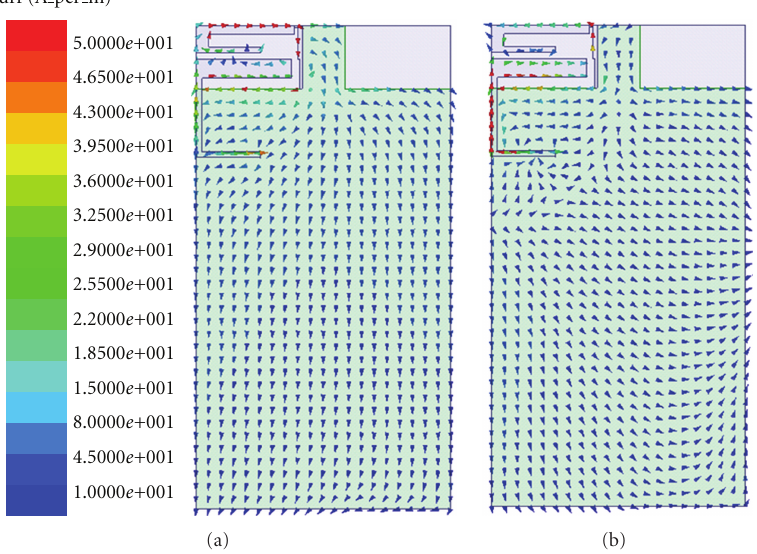
Figure 6: Current distribution at frequency of (a) 890 MHz and (b) 1940 MHz.